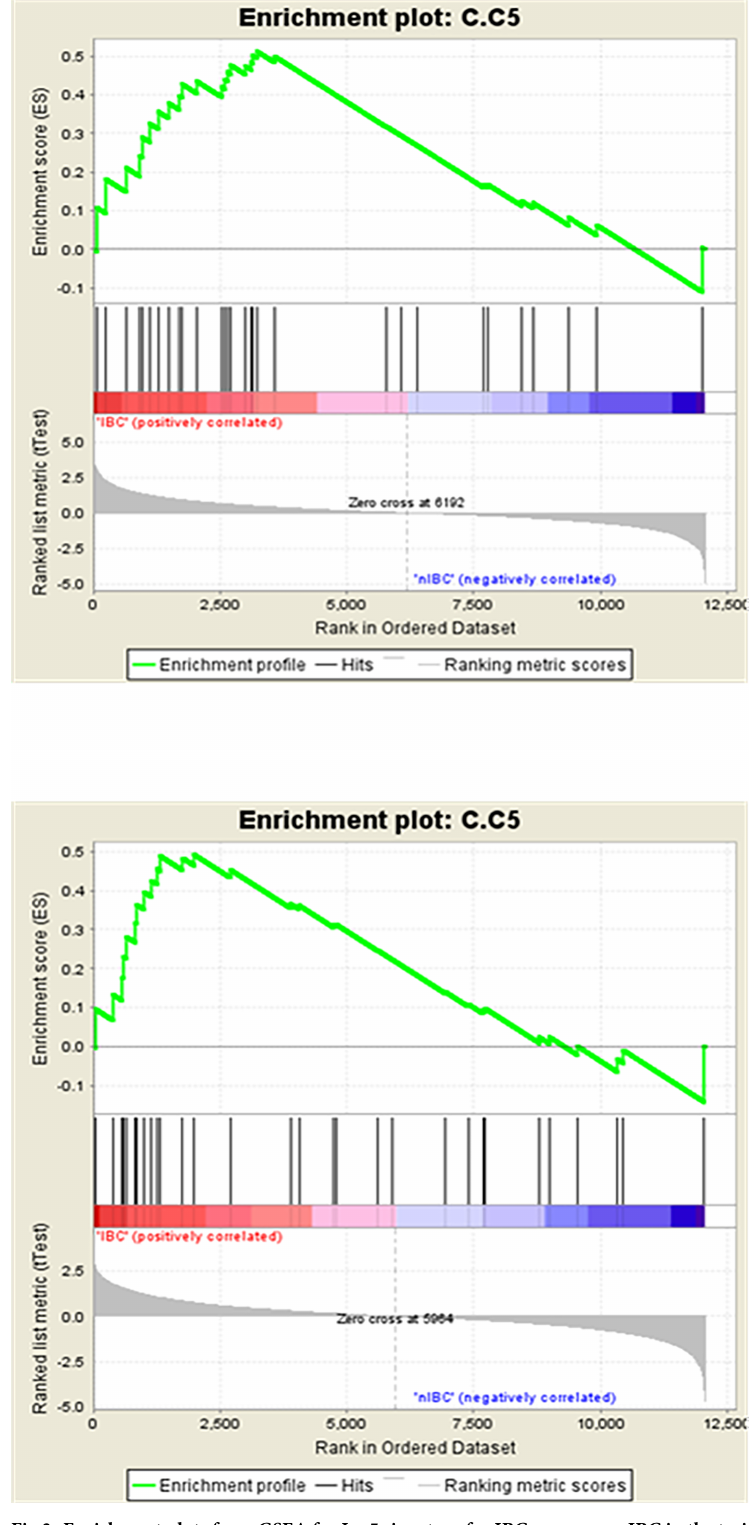
Fig 3. Enrichment plots form GSEA for Inv5 signature for IBC versus non-IBC in the training and validation sets. nIBC, non-Inflammatory breast cancer.